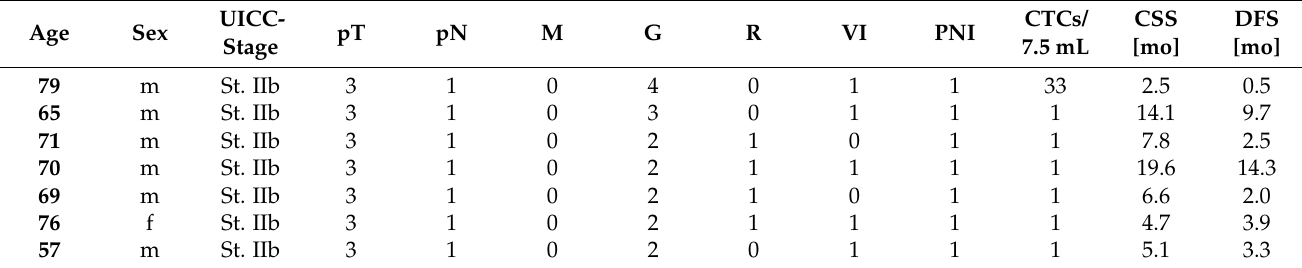
Table A2. Clinicopathological parameters and survival of patients with